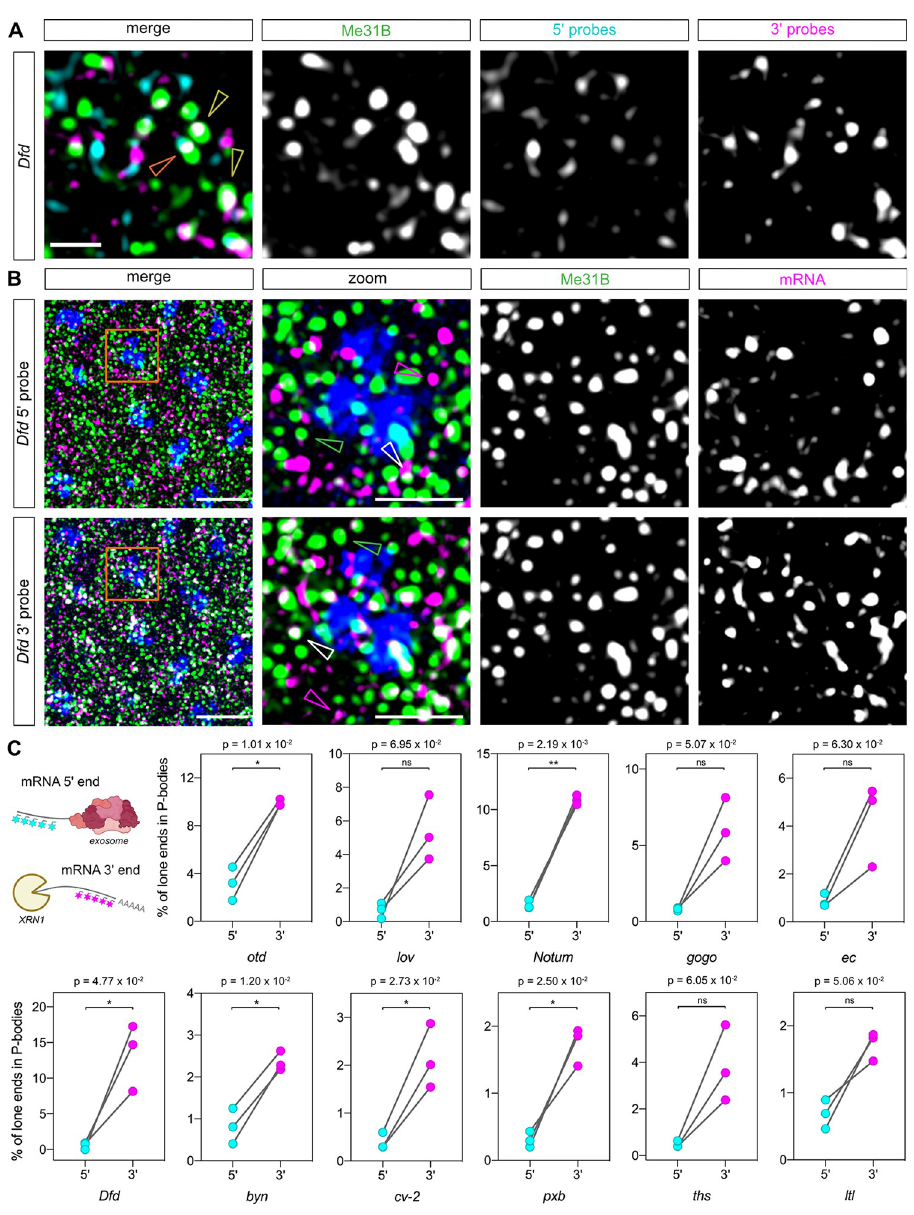
Fig 6. mRNA 3 0 end fragments are more associated with P-bodies than 5 0 ends. (A) Maximum projection (2 slices) of a confocal image showing smFISH staining of an early nc14 embryo with probes for Dfd 5 0 (cyan) and 3 0 (magenta) ends, GFP-Me31B (green). Examples where both the 5 0 and 3 0 ends or only the 3 0 end is colocalised with P-bodies are indicated by orange and yellow arrowheads, respectively. Single channels for the smFISH and GFP-Me31B images are shown with the merged image. Scale bar: 1 μ m. (B) As in (A) except the images (7 Z slices) show only 1 mRNA end (5 0 in the top panels, 3 0 in the lower panels) at a time for clarity. The mRNAs, GFP-Me31B, and DAPI are shown in magenta, green, and blue, respectively. A higher magnification image is shown as a merge and single channels, with an individual mRNA end (magenta arrowhead), P-body (green arrowhead), and colocalised mRNA end and P-body signals (white arrowhead) highlighted. Scale bars: 5 μ m in merge and 2 μ m in the higher magnification image. (C) Top left: Schematic showing how degradation by either pathway would result in a single fluorophore signal being detected. Quantification of the percentage of unpaired mRNA 5 0 and 3 0 ends colocalised with P-bodies relative to the total number of lone 5 0 or 3 0 ends; n = 3 embryos, paired t test used to determine significance with α = 0.05. For absolute numbers of intact mRNAs and lone ends, see S9A and S9C Fig. Underlying data can be found in S1 Data. smFISH, single-molecule fluorescent in situ